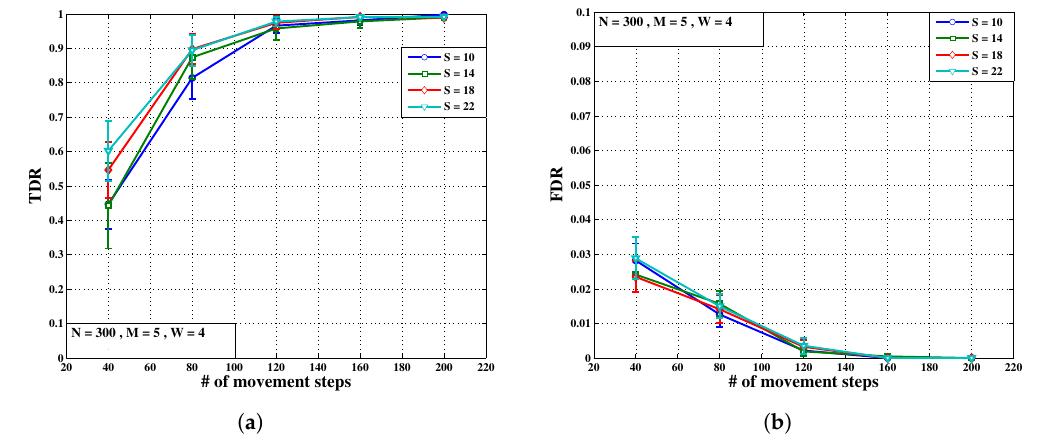
Figure 7. Variation of TDR ( a ) and FDR ( b ) versus time for different number of Sybil IDs.